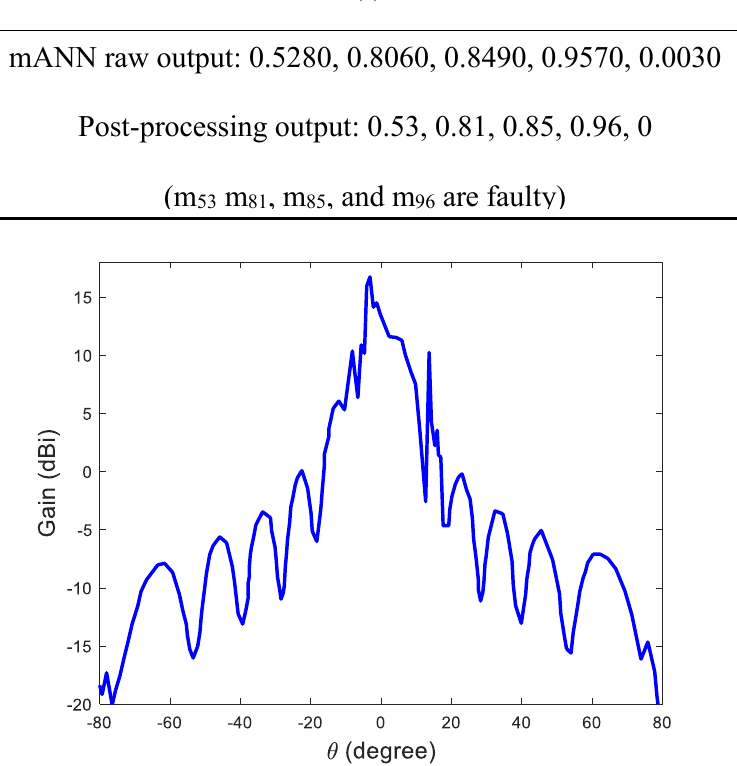
(d) FIGURE 10 [c, d]. Radiation pattern of fault (s) and corresponding multivalued ANN output in the insets. (c) Radiation pattern with three elements ( 𝑚 ), , 𝑚 -. ,𝑚 .- ) faults (d) Radiation pattern with four elements ( 𝑚 /’ ,𝑚 *+ ,𝑚 */ ,𝑚 .( )